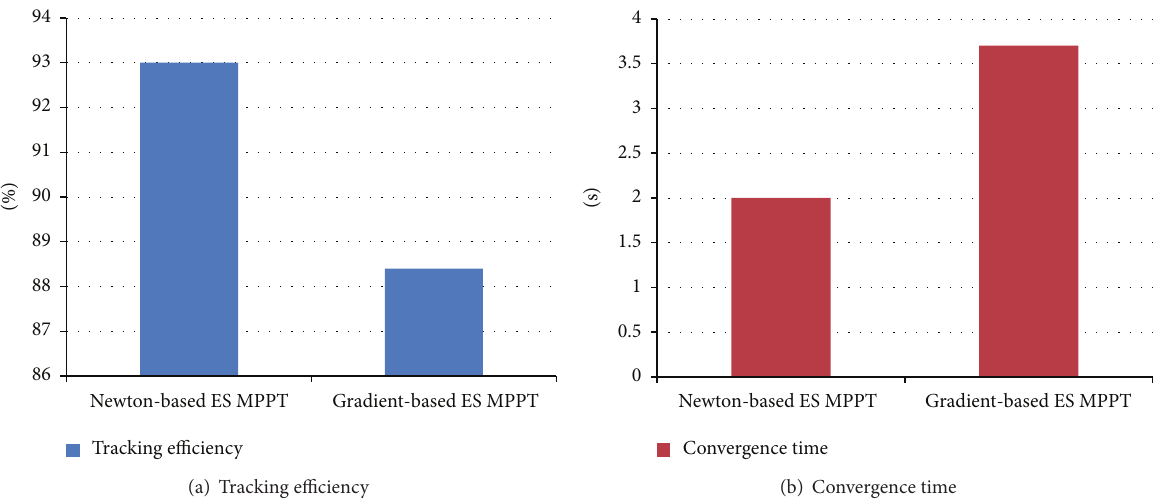
Figure 18: The numerical comparison between the proposed MPPT algorithm and classical extremum seeking MPPT algorithm under irradiance 1000W/m 2